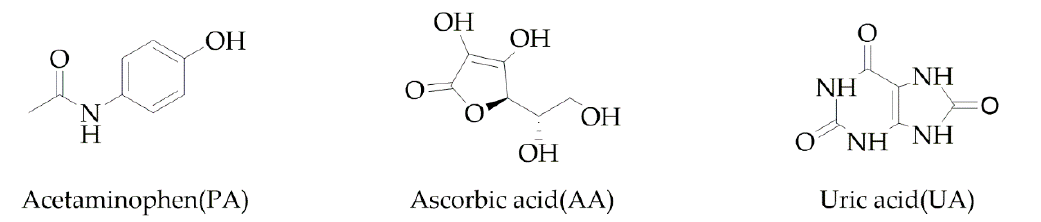
Figure 1. Chemical structure of three studied compounds in this report (Acetaminophen, Ascorbic acid and Uric acid).